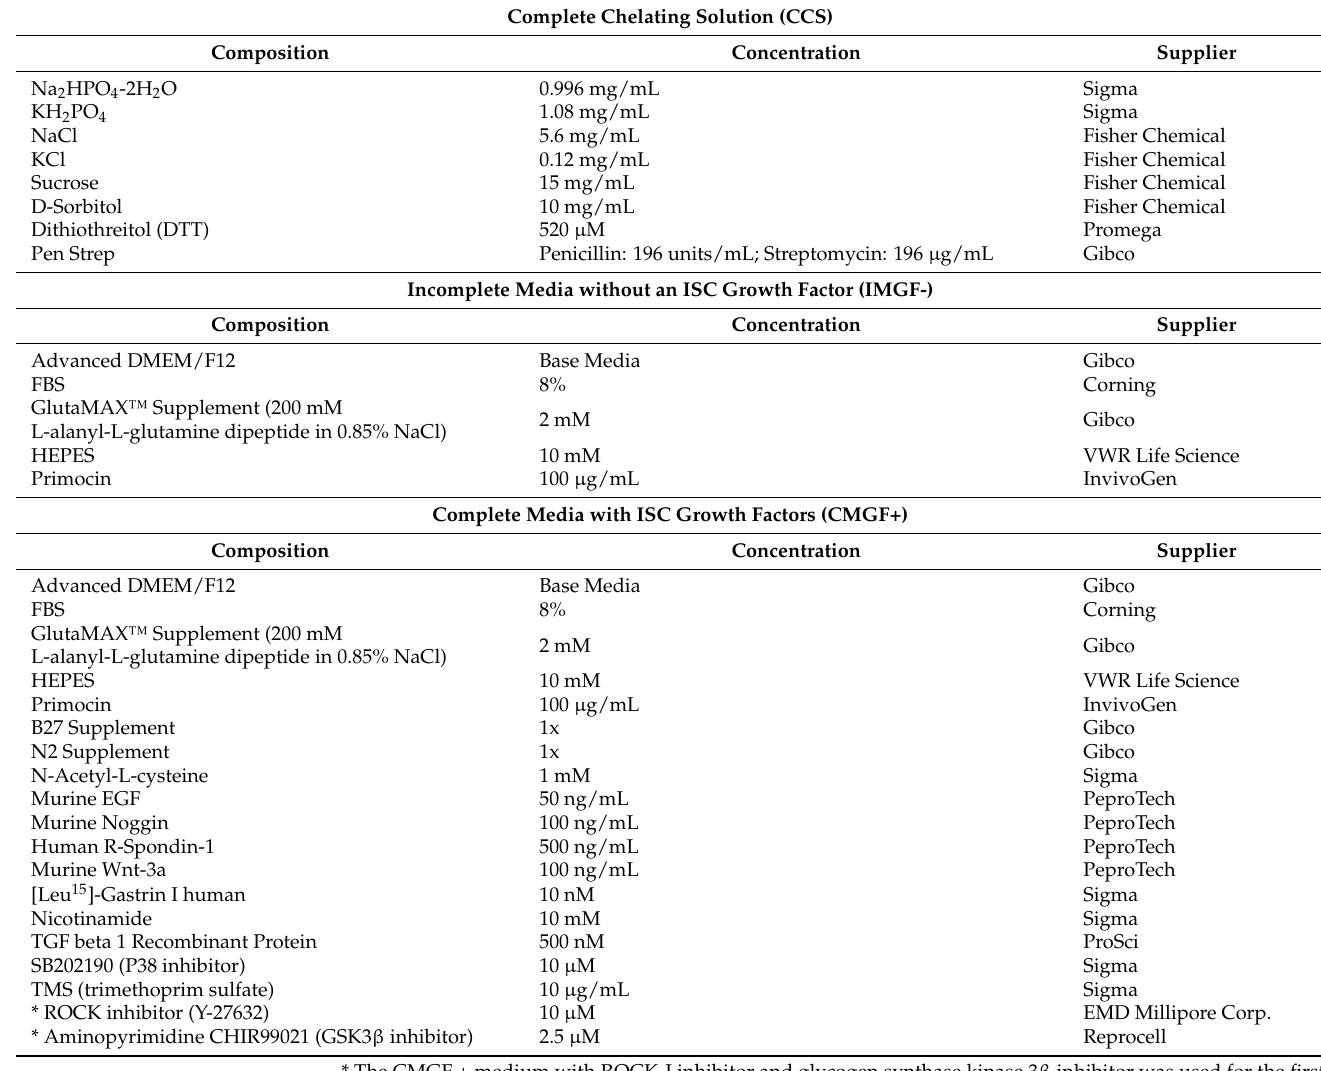
Table 1. The composition of complete chelating solution (CCS) and organoid culture